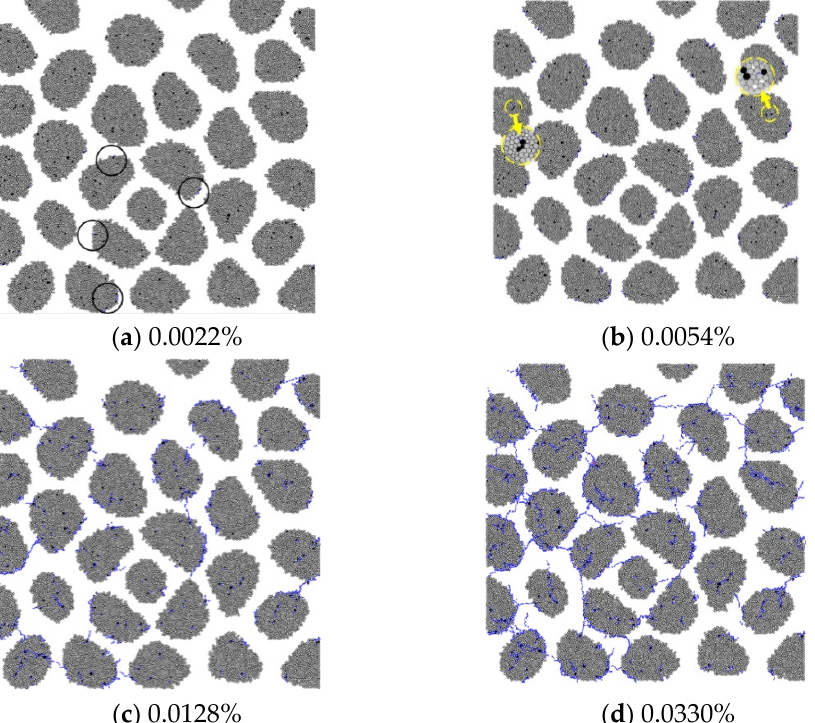
Figure 4. AAR-induced microcracks in GC20-1-1.5%.